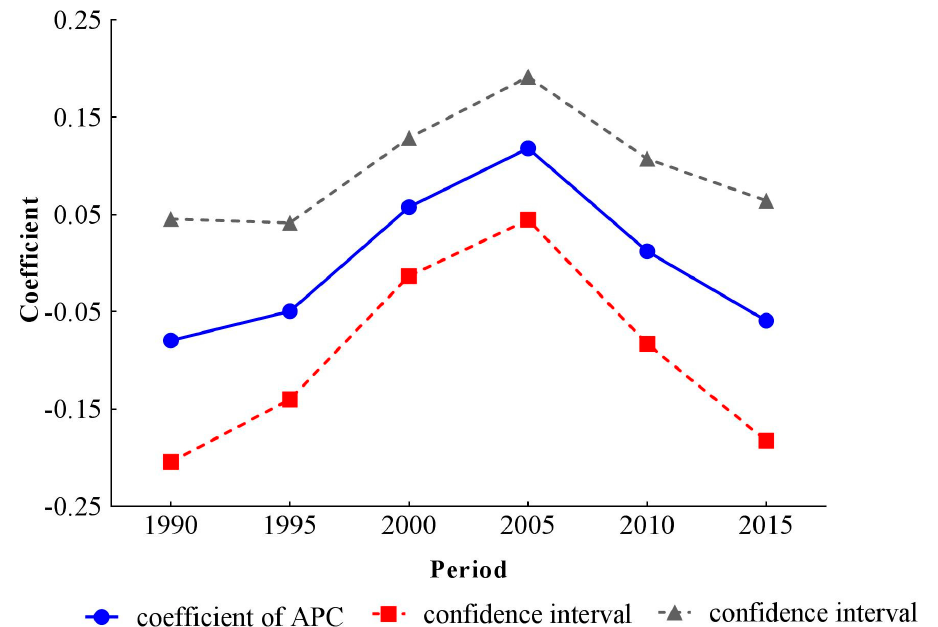
Figure 6. Period effects on stroke mortality PM 2.5 in China.